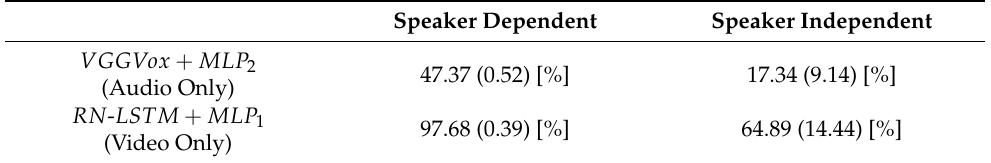
Audio/video results using the Columbia dataset with respect to Mean Accuracy (Standard Deviation).